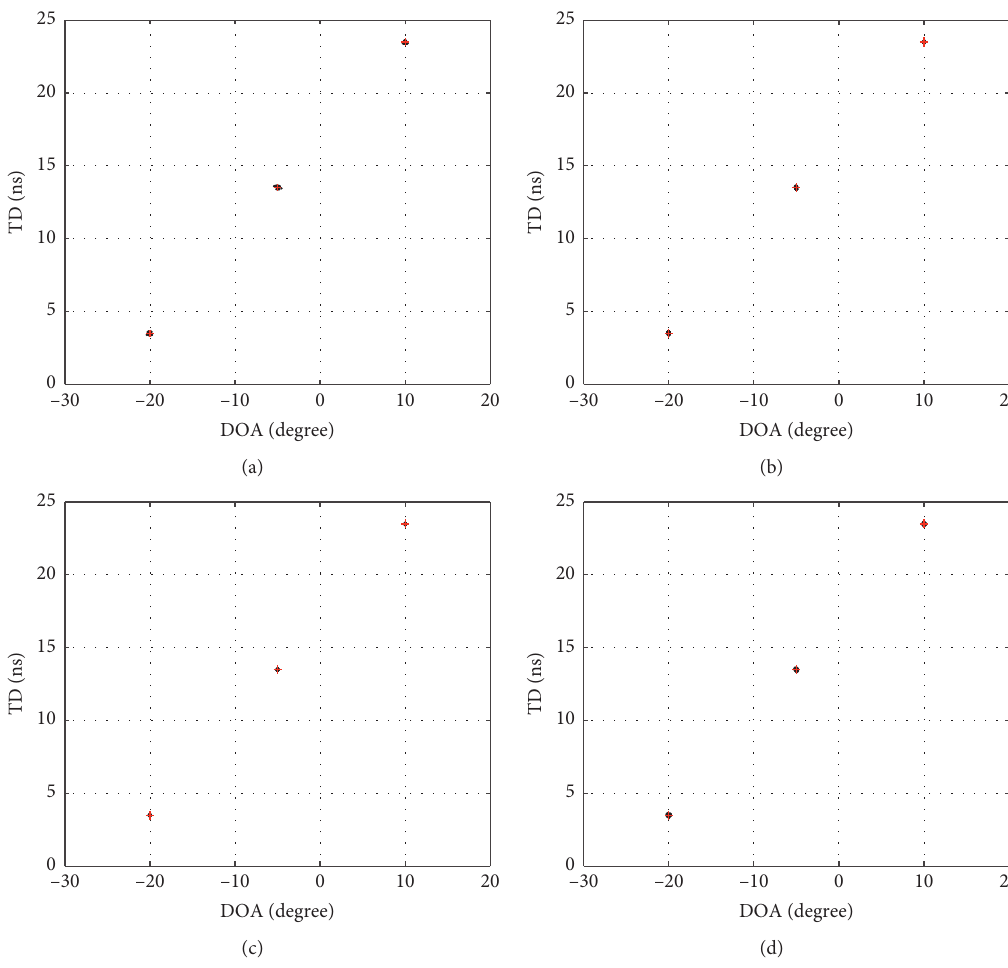
Figure 3: Estimation results distribution under different conditions: (a) condition 1, SNR �− 5dB; (b) condition 2, SNR �− 5 dB; (c) condition 3, SNR � − 5dB; and (d) condition 1, SNR �